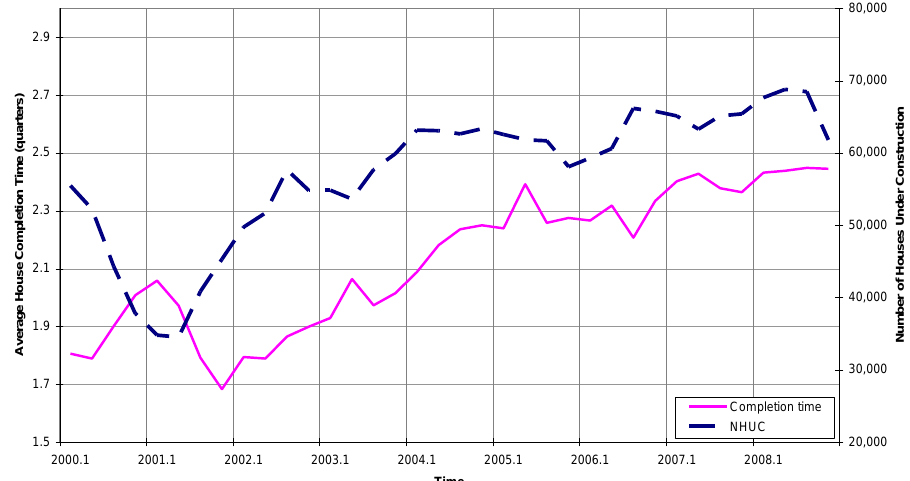
Figure 12: the trend of number of houses under construction and the average house completion time in